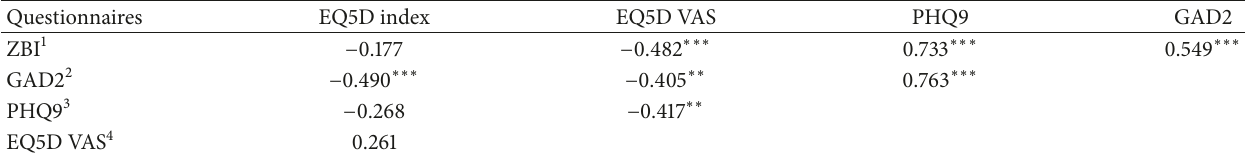
Table 3: Correlation coefficients between spouses’ burden, depression, anxiety, and quality of life.